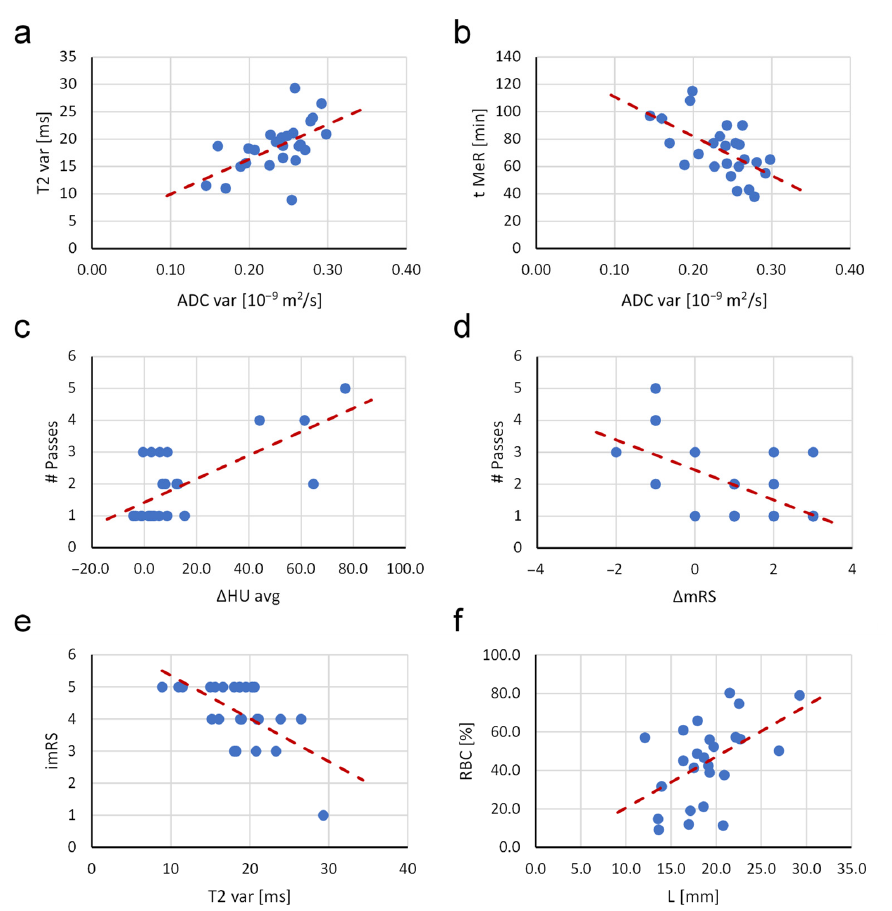
Figure 6. Plots of correlations between selected pairs of thrombi parameters: ( a ) T2_var vs. ADC_var, ( b ) t_MeR vs. ADC_var, ( c ) # Passes vs. ∆ HU_avg, ( d ) # Passes vs. ∆ mRS, ( e ) imRS vs. T2_var, ( f ) RBC % vs. L. Red dashed lines indicate trend lines of the data.